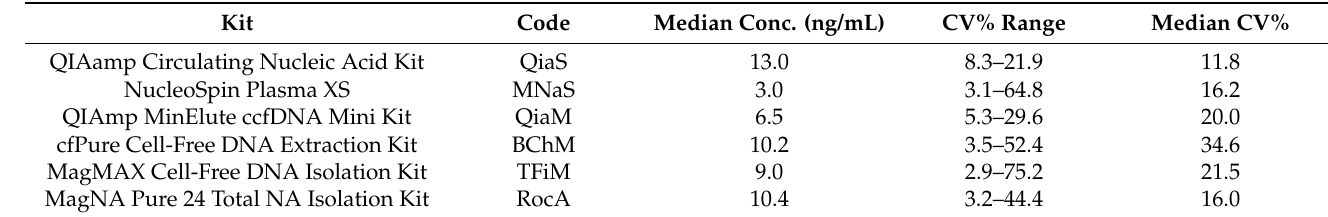
Table 2. Reproducibility of cfDNA recovery of different